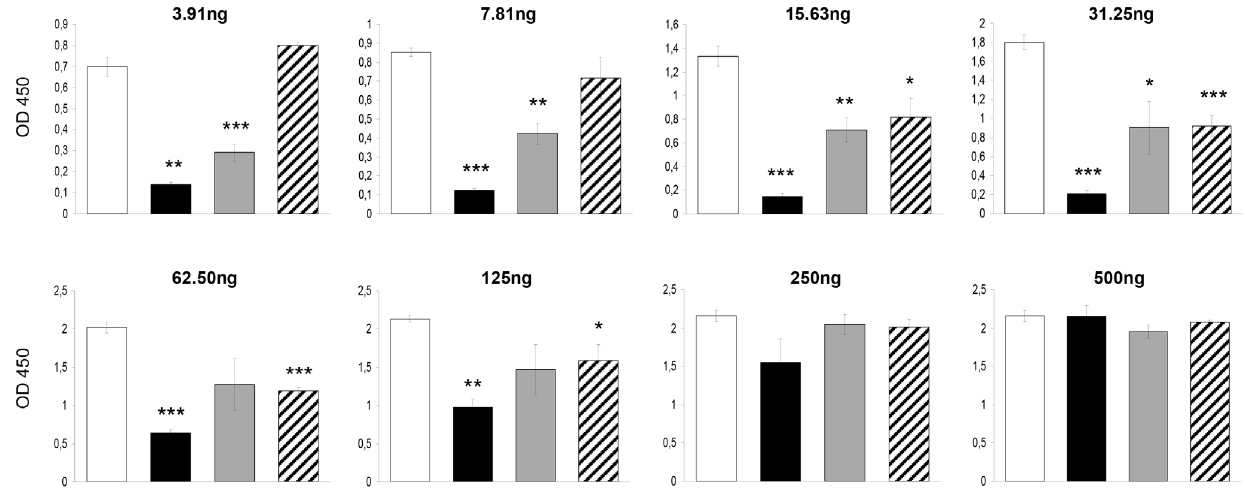
Figure 6. Inhibitory ability of bovine lactoferrin (bLF) on the binding of CT (gradient of concentration) to GM1 by GM1-ELISA. CT was added at a two fold increase in doses (3.91–500 ng) after (black bars), together (grey bars) or before (striped boxes) the bovine lactoferrin administration, and incubated in total for 3 h. The white bars represent the control group (CT alone). The absorbance was read at 450 nm in an ELISA plate reader. Values are mean 6 standard desviation of three independent assays. *, p , .05; **, p , .01; ***, p , .001 for the comparison of bLF groups vs. CT group (CT alone), by unpaired t test.